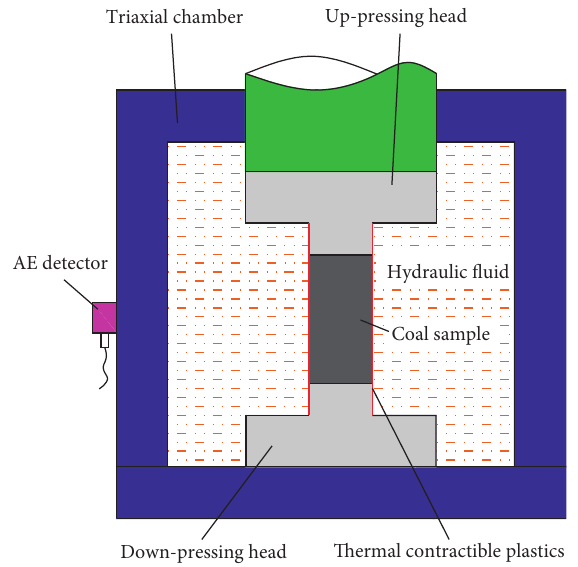
Figure 2: AE detector placed outside the triaxial chamber.